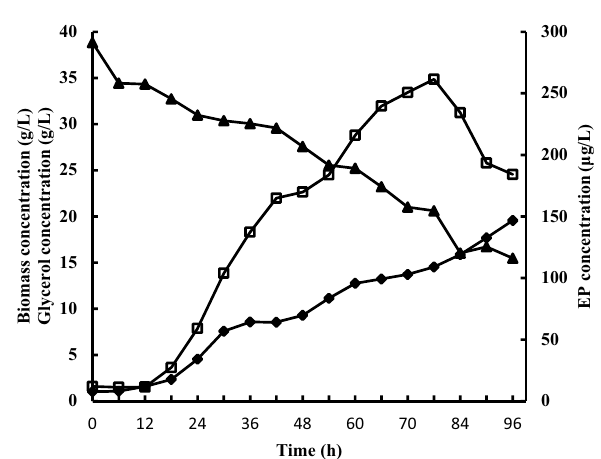
Figure 4. Changing profiles of biomass, EP, and glycerol consumption at different time points. ♦ : Biomass concentration; ▲ : Glycerol concentration; □ : EP